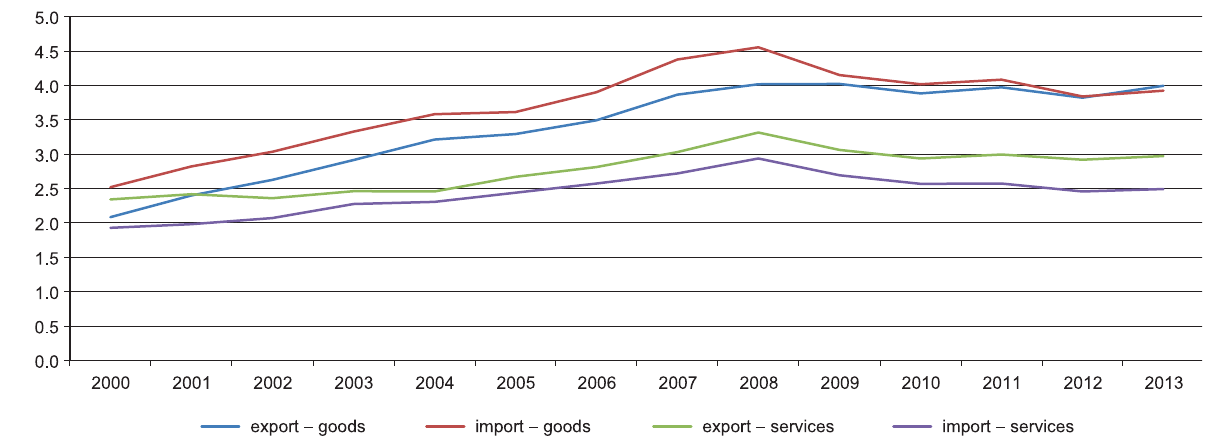
Fig. 2. The contribution of post-communist countries to global exports and imports of commodities and services, the years 2000–2012. Source: developed by the authors on the basis of the OECD-WTO